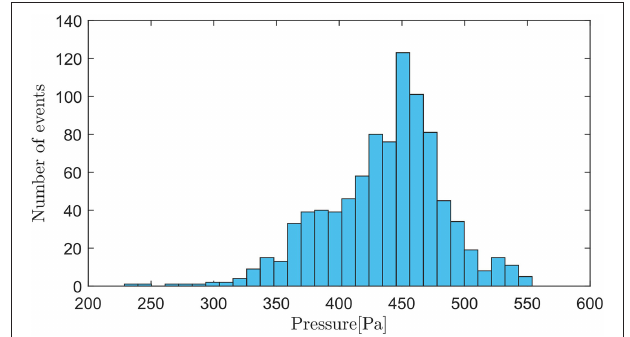
FIGURE 12 | Distribution of avalanches starting pressures (black dots in Figure 8